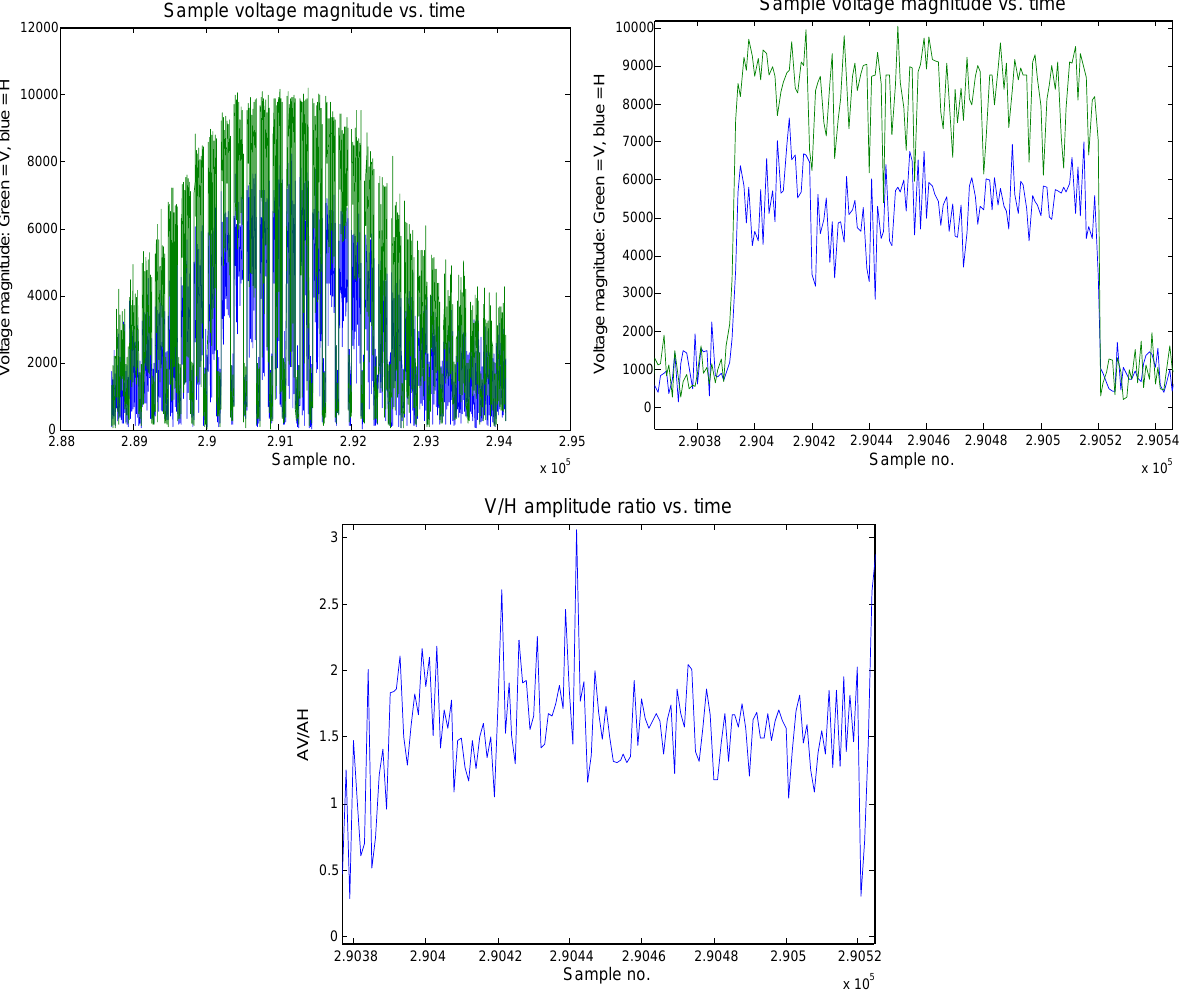
Sample voltage magnitude vs. time